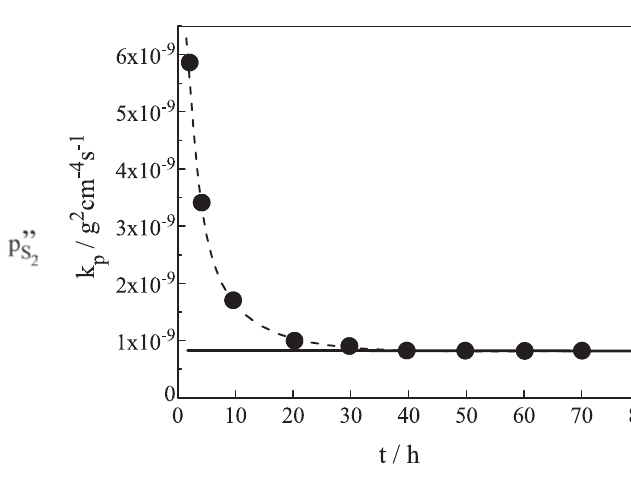
Fig. 7: Concentration gradients of point defects in the NiS 2 layer, growing on NiS by the outward diffusion of cations: a) cation vacancies predominate, b) interstitial cations predominate